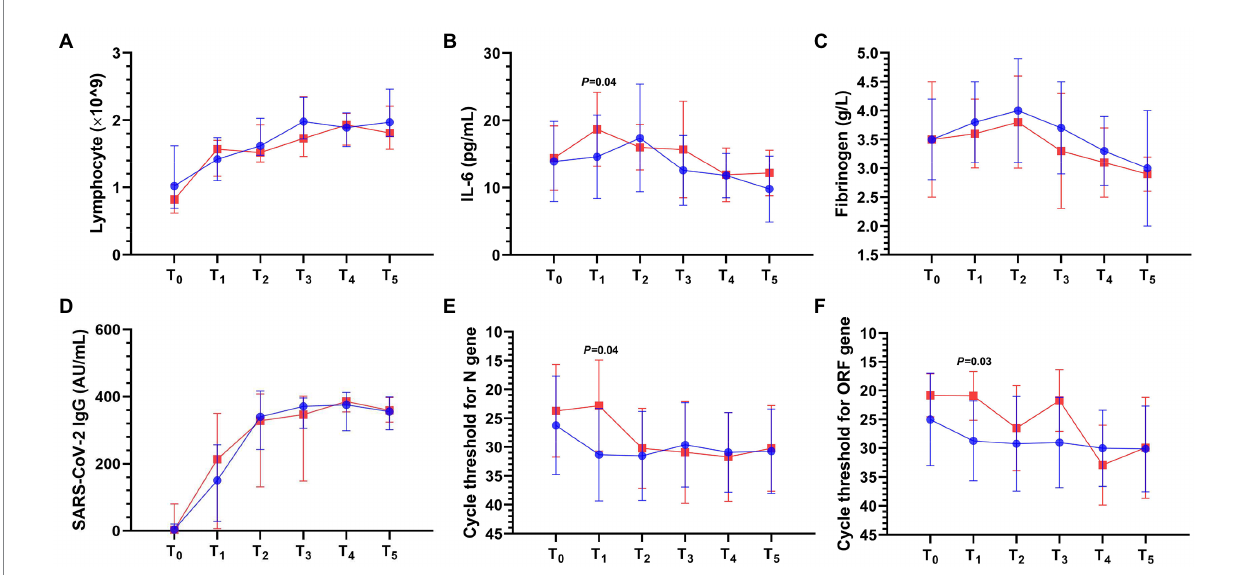
FIGURE 2 Laboratory result dynamics in the first day after admission (T 0 ) and simultaneous time periods from T 1 to T 5 after the onset of COVID-19 pneumonia. T 1 to T 5 represent the following: T 1 ≤ 3; 3 < T 2 ≤ 7; 7 < T 3 ≤ 14; 14 < T 4 ≤ 21; 21 < T 5 ≤ 28 days. IL-6, interleukin-6; SARS-CoV-2, severe acute respiratory syndrome coronavirus-2. The blue or red connecting line and symbols represent the control or VDD group, n = 8–28 or n = 5–18 per condition, respectively. Symbols and error bars in the line chart represent median and interquartile range (A,D) or mean and standard deviation (B,C,E,F) . (A) Lymphocyte. (B) IL-6 in the VDD group was higher (18.7 ± 5.5 vs. 14.6 ± 6.2 pg/ml) than that in the control group within 3 days. (C) Fibrinogen. (D) SARS-CoV-2 IgG titer. (E) Cycle threshold for N gene in the VDD group was lower (22.8 ± 7.9 vs. 31.3 ± 8) than that in the control group within 3 days. (F) Cycle threshold for ORF1ab gene in the VDD group was lower (20.9 ± 4.2 vs. 28.7 ± 6.9) than that in the control group within 3